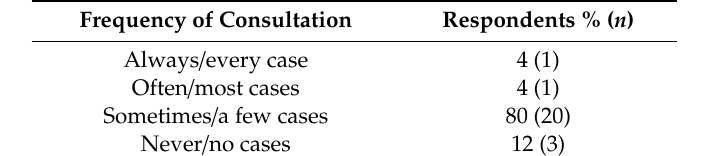
Table 3. Respondents were asked “In the past 12 months, how often did your clients consult you before euthanizing a pig?” ( n = 25).